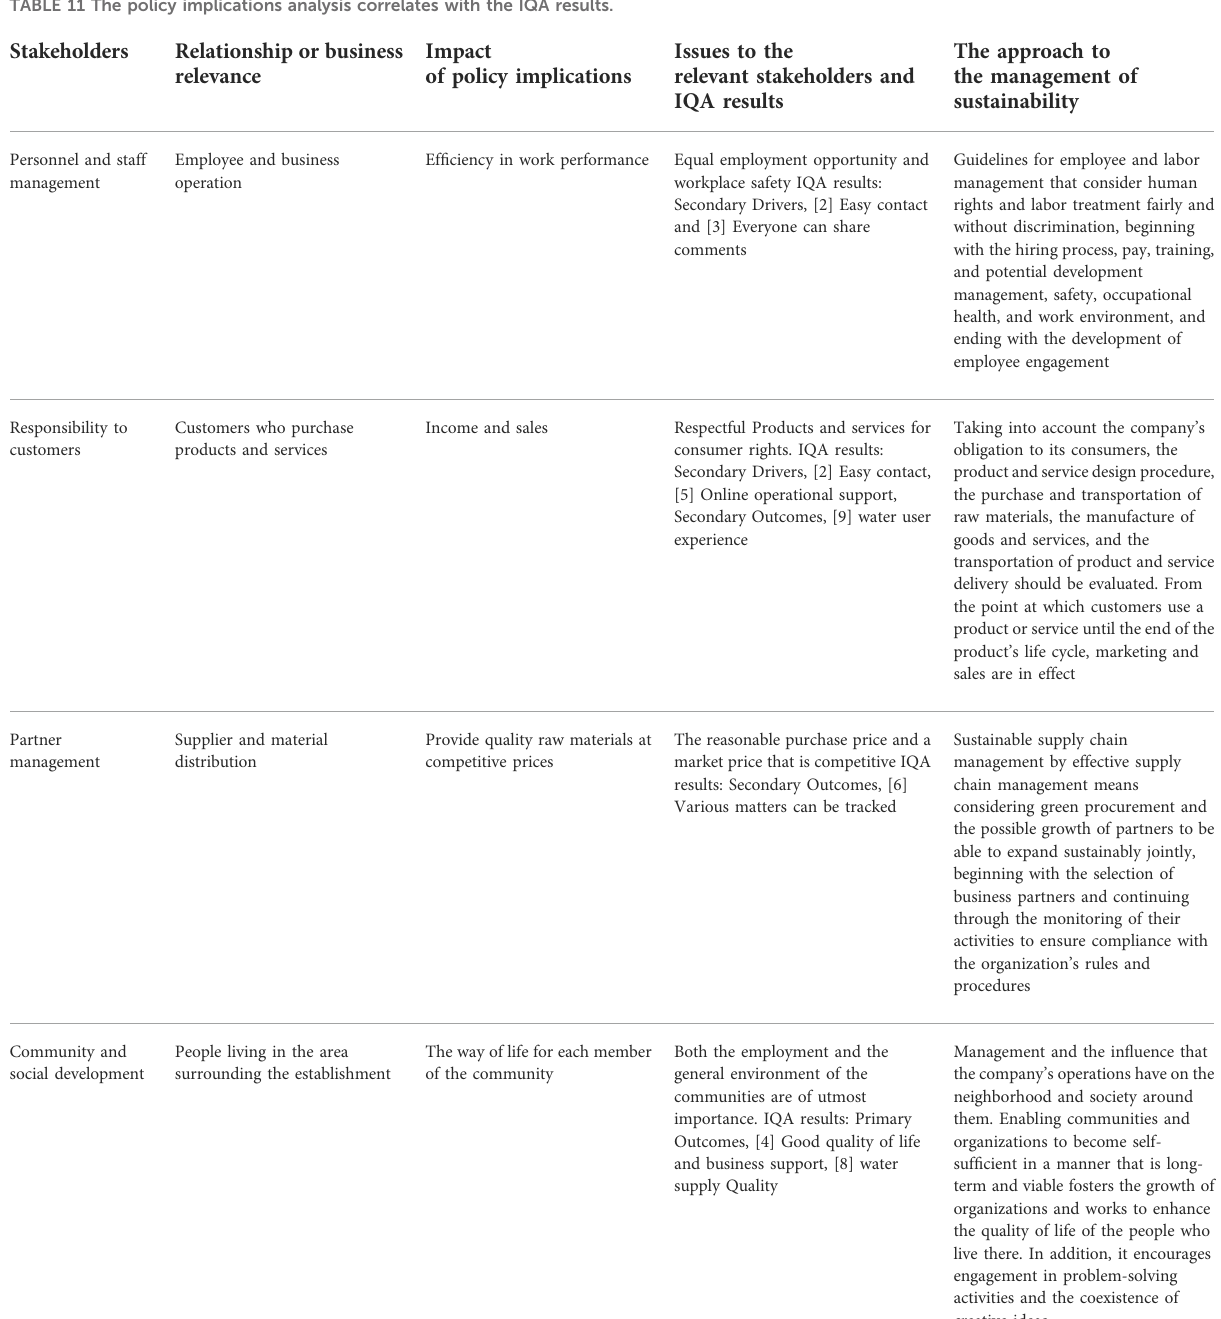
TABLE 11 The policy implications analysis correlates with the IQA